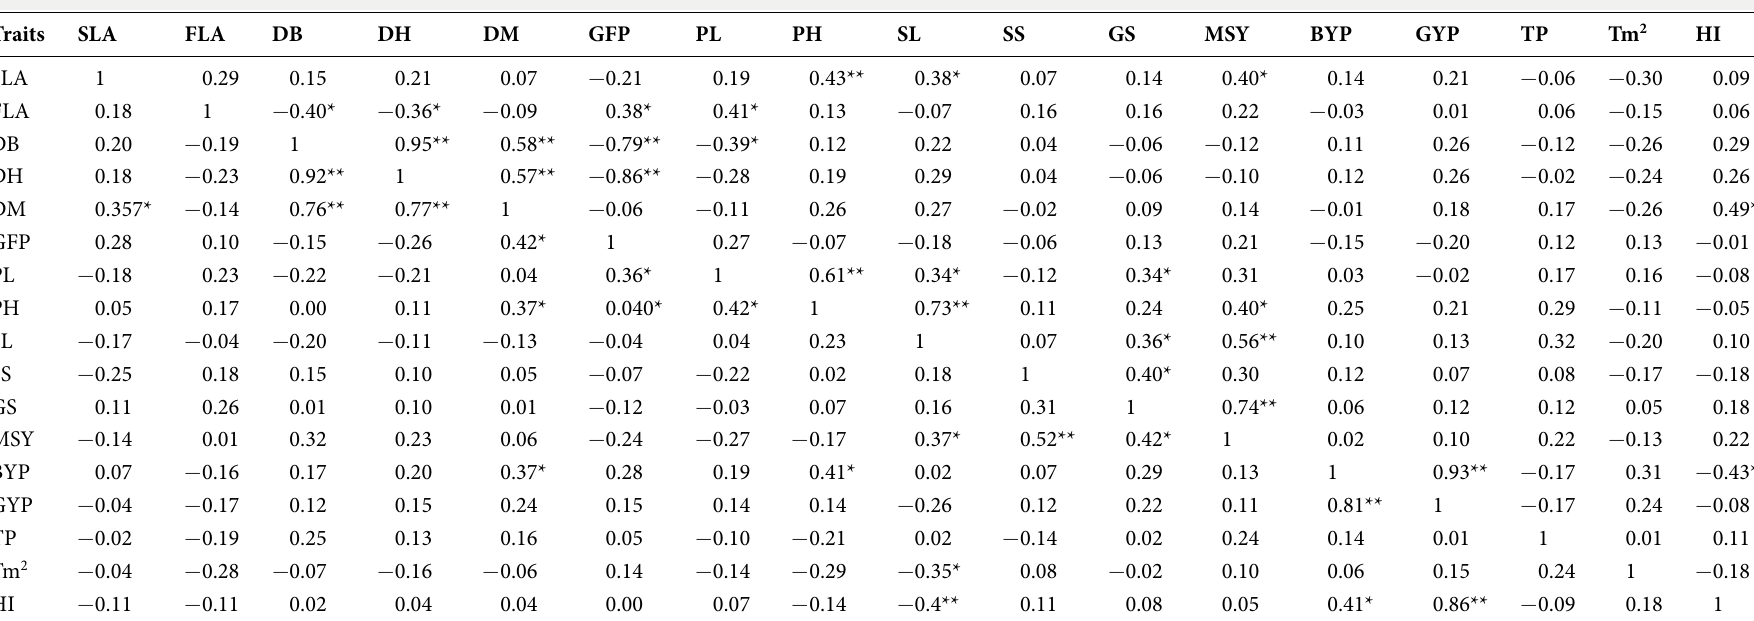
Table 5 Pearson’s correlation coefficients ( r ) among agronomic traits of the wheat genotypes observed in moisture stress (MS) (upper diagonal) and well-watered (WW) conditions (lower diagonal).